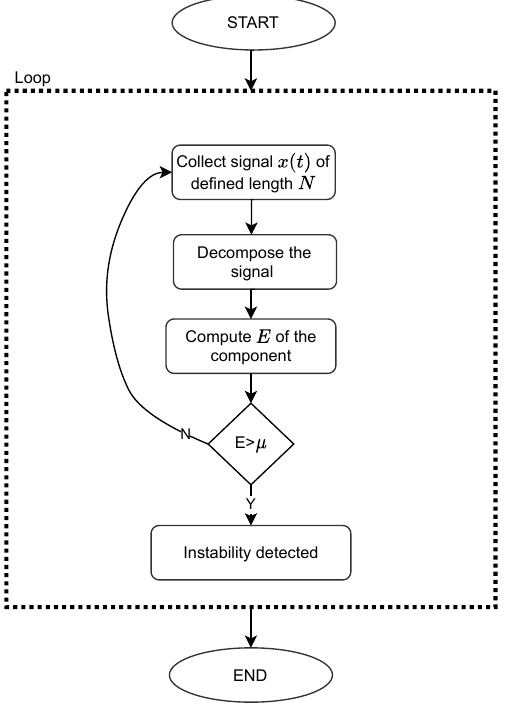
Figure 1. Flowchart of a detection